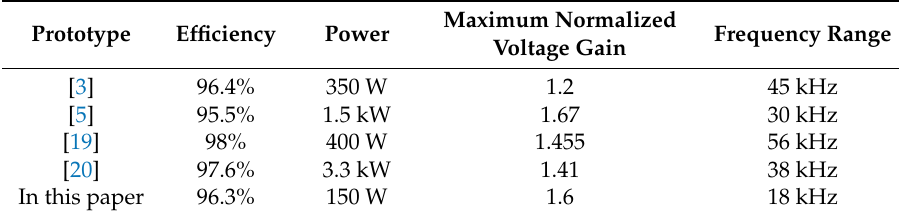
Table 2. Fair comparison to the other published